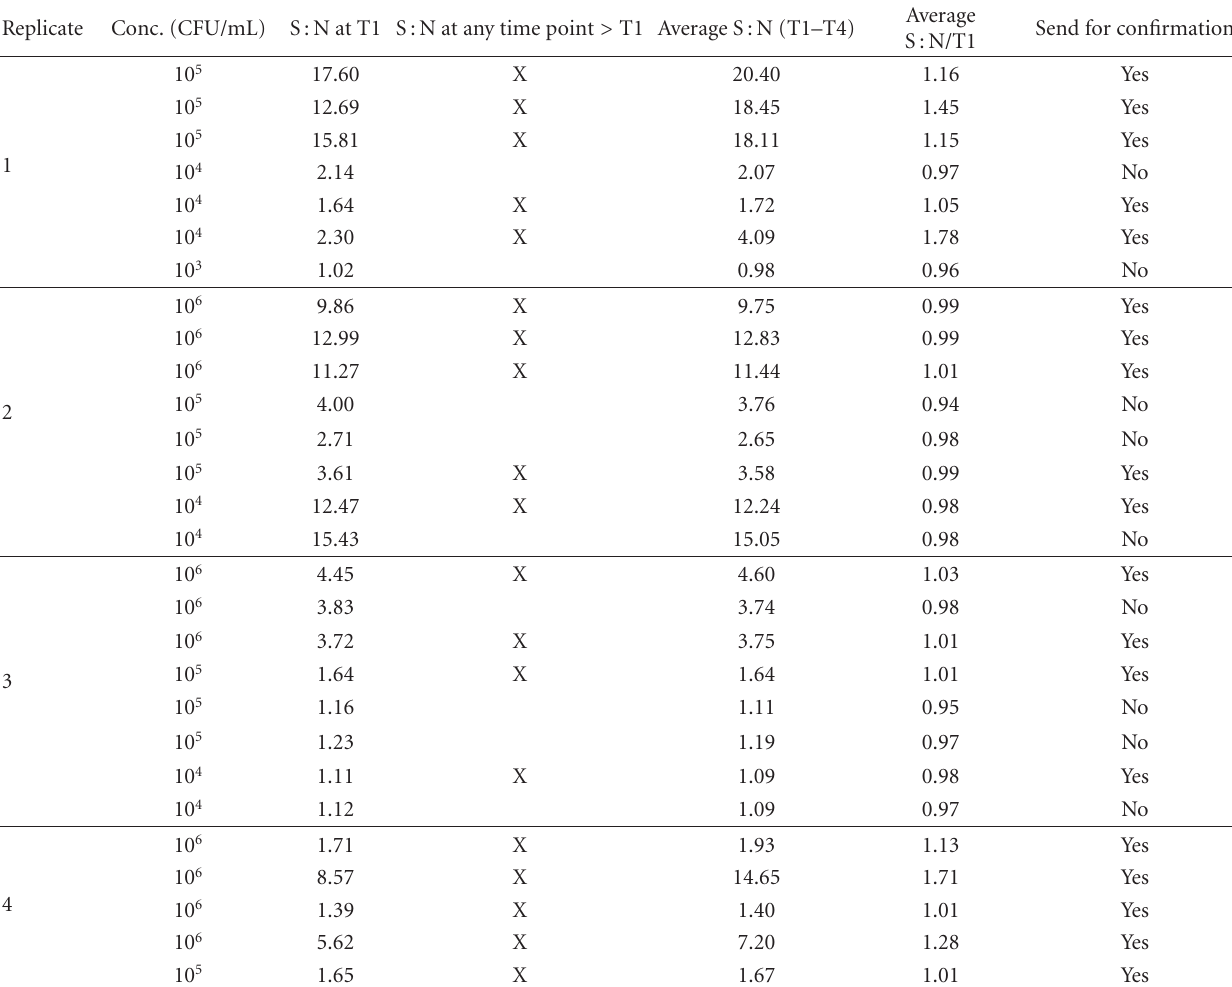
Table 1: Summary results for detection of MTB in synthetic urine—blinded assays. Replicate